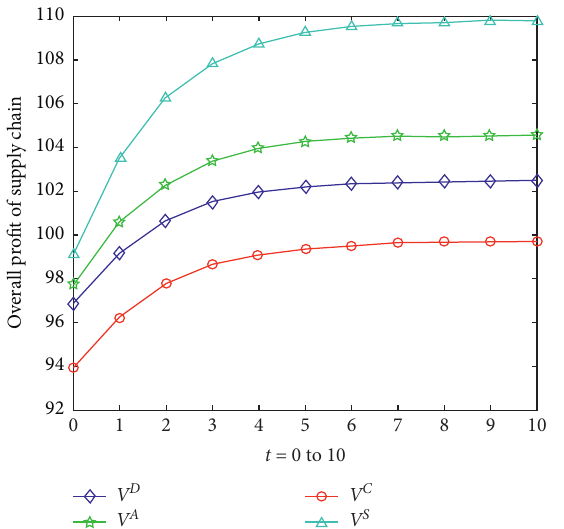
Figure 1: The optimal trajectory of supply chain profits under benchmark parameters.